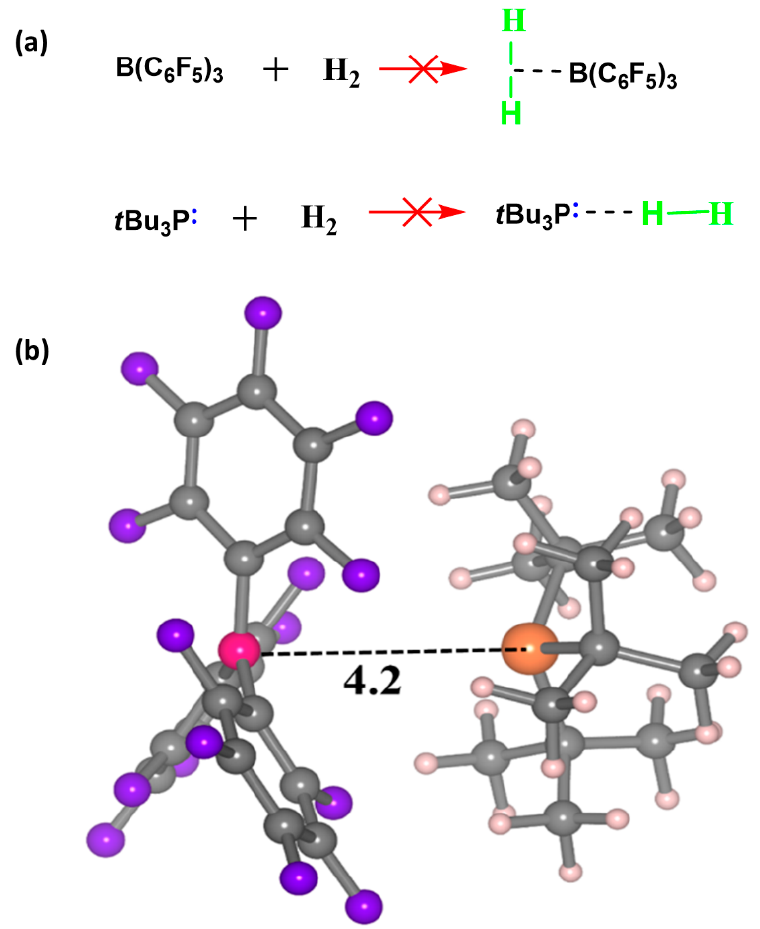
Figure 1. ( a ) Two proposed intermediates for the reactivity of B(C 6 F 5 ) 3 and t Bu 3 P towards H 2. ( b ) Structure of an “encounter complex” formed by a combination of B(C 6 F 5 ) 3 and P t Bu 3 pair, where the distance between boron (pink) and phosphorous (yellow) centers are given in angstrom.